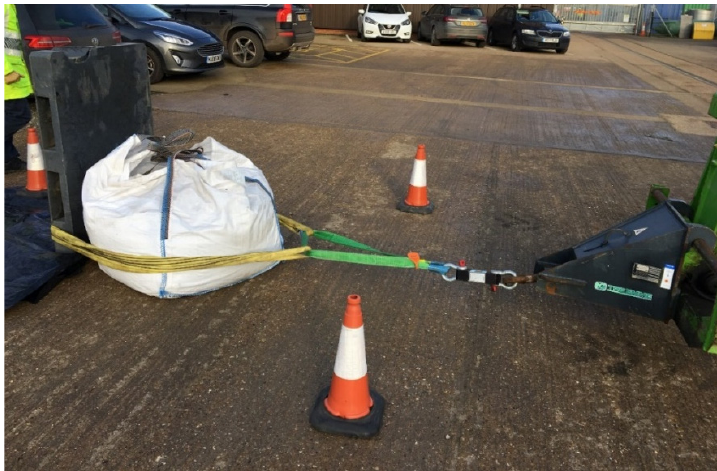
Figure 6. Single bulk bag subject to lateral tensile force during testing of surface C.